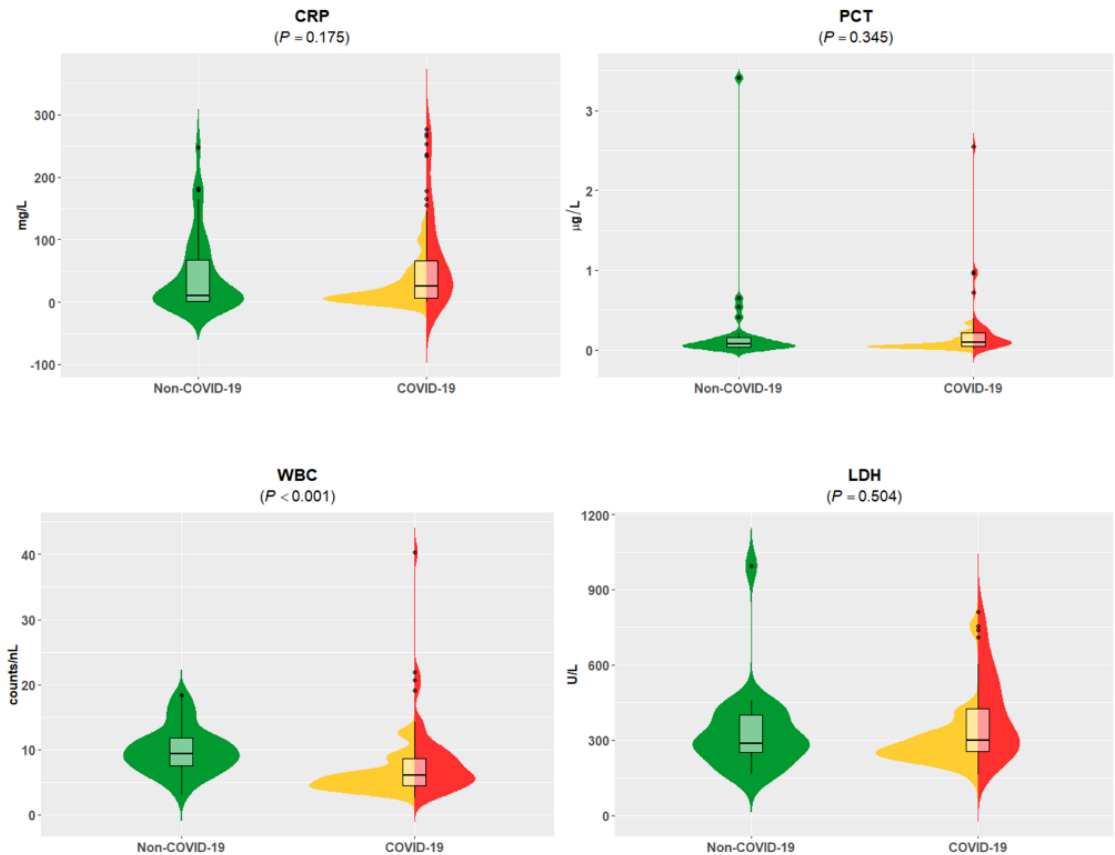
Figure 2. Standard of care parameter-values of C-reactive protein (CRP), procalcitonin (PCT), white blood cell (WBC) counts, and lactate dehydrogenase (LDH) of combined groups without COVID-19 were compared to COVID-19 hospitalized and non-hospitalized patients. Data are visualized by violin plots, which are a combination of kernel density plots, and box plots depicting median, 25th, and 75th percentiles. No significant differences were detectable for CRP, PCT, and LDH. Units are as follows: CRP (mg/L), PCT (µg/L), WBC (cells/nL), LDH (U/L). Significantly lower WBC levels were found in patients with confirmed SARS-CoV-2 infection compared to non-COVID-19 patients ( p < 0.001). Green = non-COVID-19; yellow = COVID-19 without hospitalization; red = COVID-19 with hospitalization; black dots: outliers.